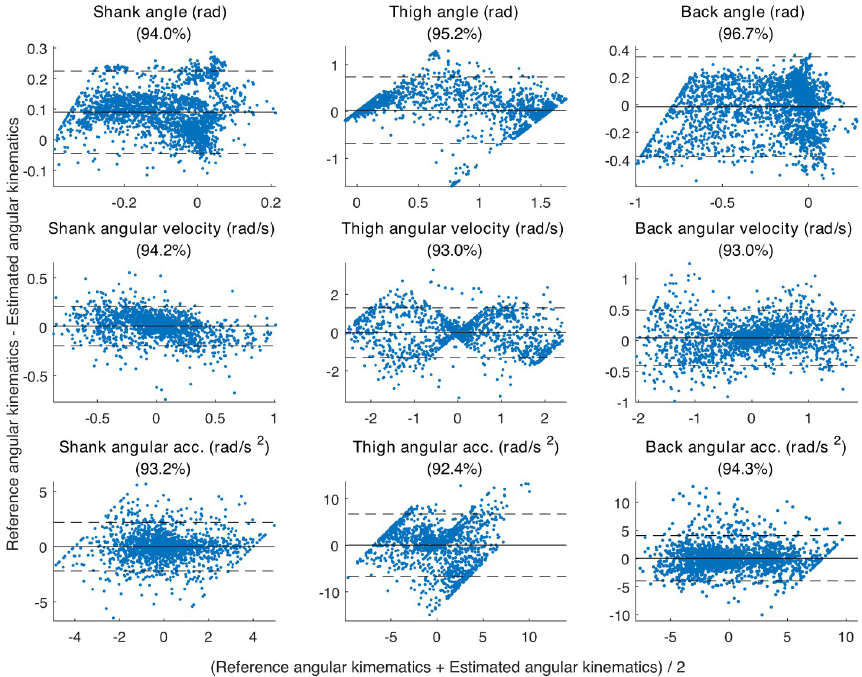
Fig 7. Bland-Altman plots. The Bland-Altman plots showing comparison between the reference Codamotion angular kinematics and estimated angular kinematics using the proposed integrated approach of modelling and classification for the shank, thigh and back. The x-axis shows the mean of the two measures and the y-axis shows the difference between the two measures. The solid horizontal represents the mean difference between the reference and estimated kinematics and the dotted horizontal lines show the ± 2 standard deviation boundaries. A Bland-Altman plot typically looks for points to be within ± 2 standard deviations of the mean difference, the title of each sub-figure has this as